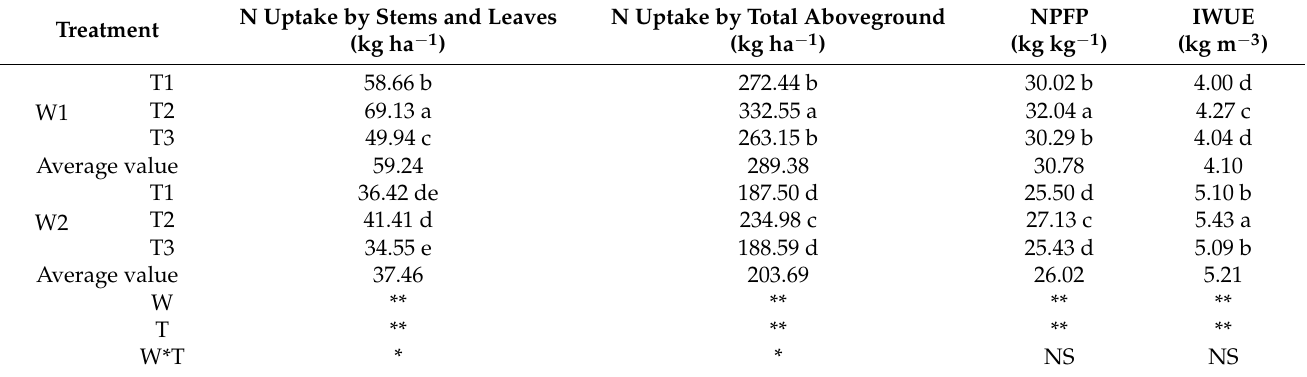
Table 4. Effects of irrigation rate and fertilization timing on N uptake, irrigation water use efficiency (IWUE), and nitrogen partial factor productivity (NPFP) of winter